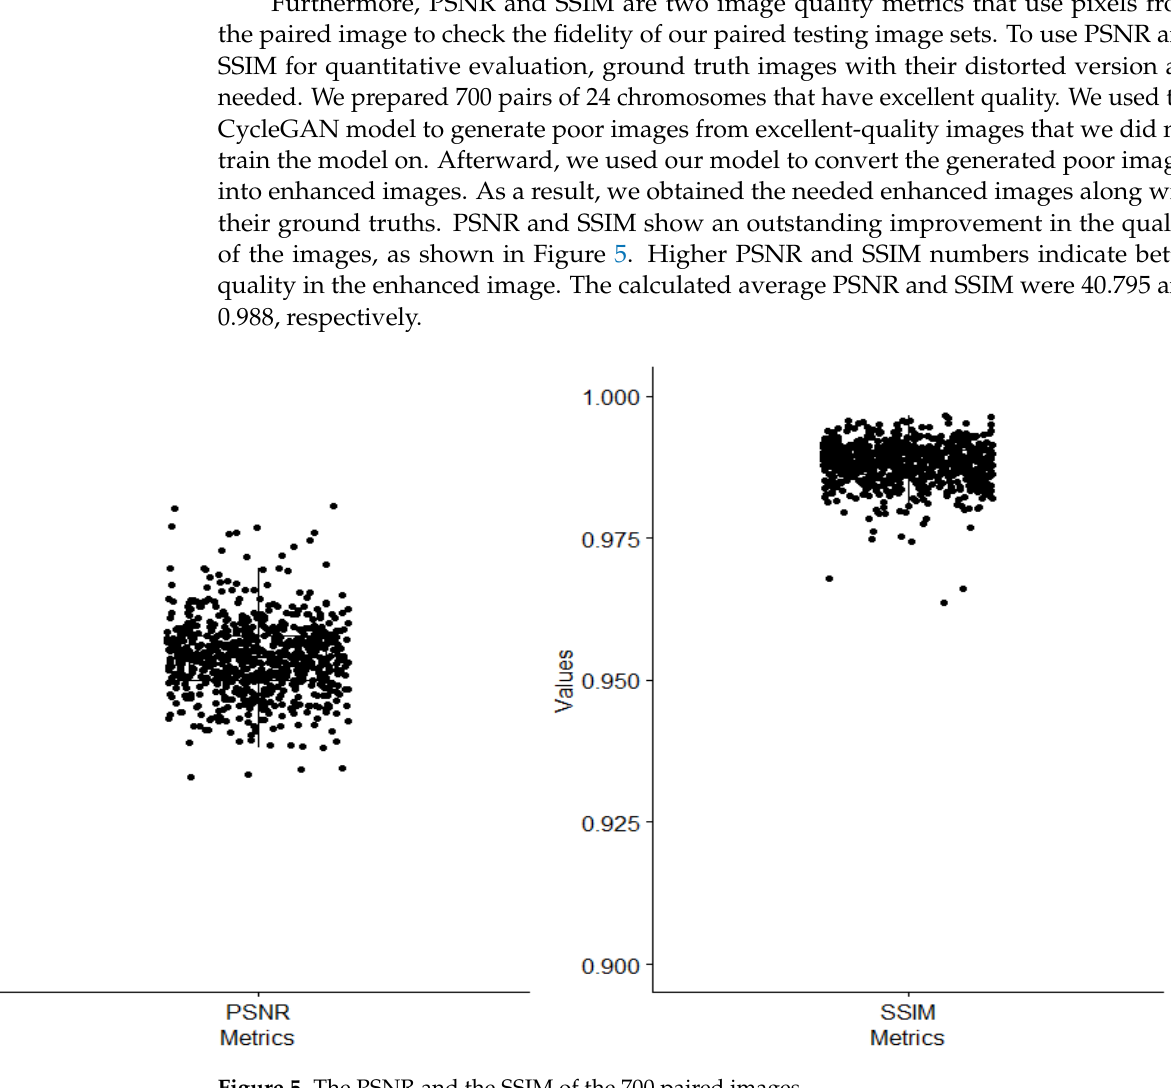
Figure 5. The PSNR and the SSIM of the 700 paired images.